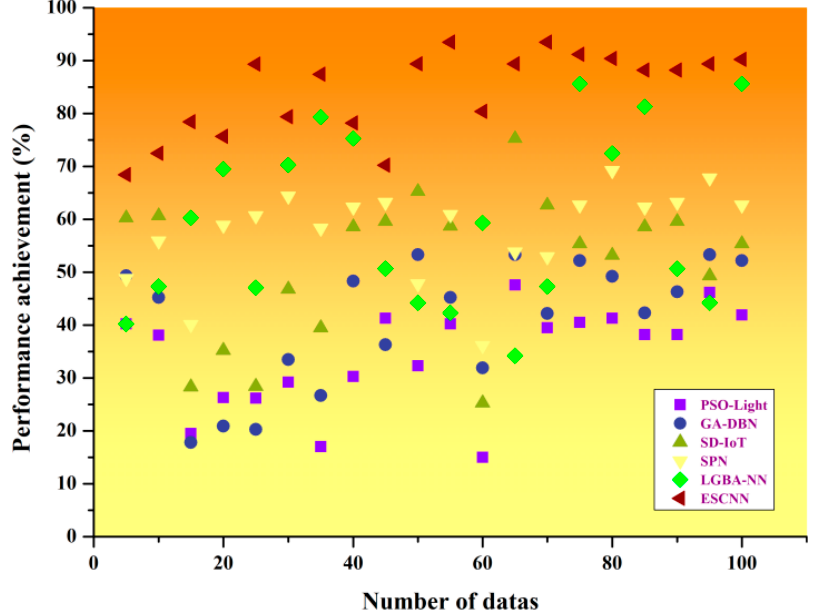
Figure 9. Overall performance analysis.